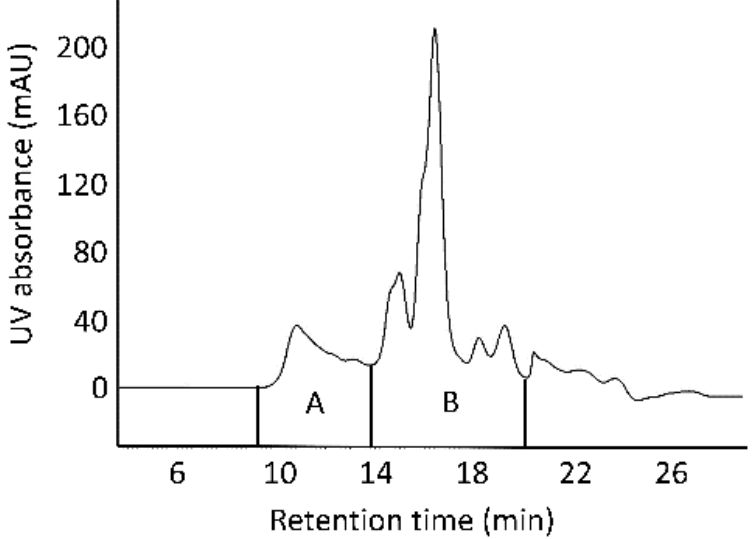
Figure 2. Size-exclusion high-performance liquid chromatography (SE-HPLC) chromatogram of the protein extracted with 30% 1-propanol (pH 7.0) from high-protein flour (HF). “A” represents protein aggregates and “B” monomeric proteins.